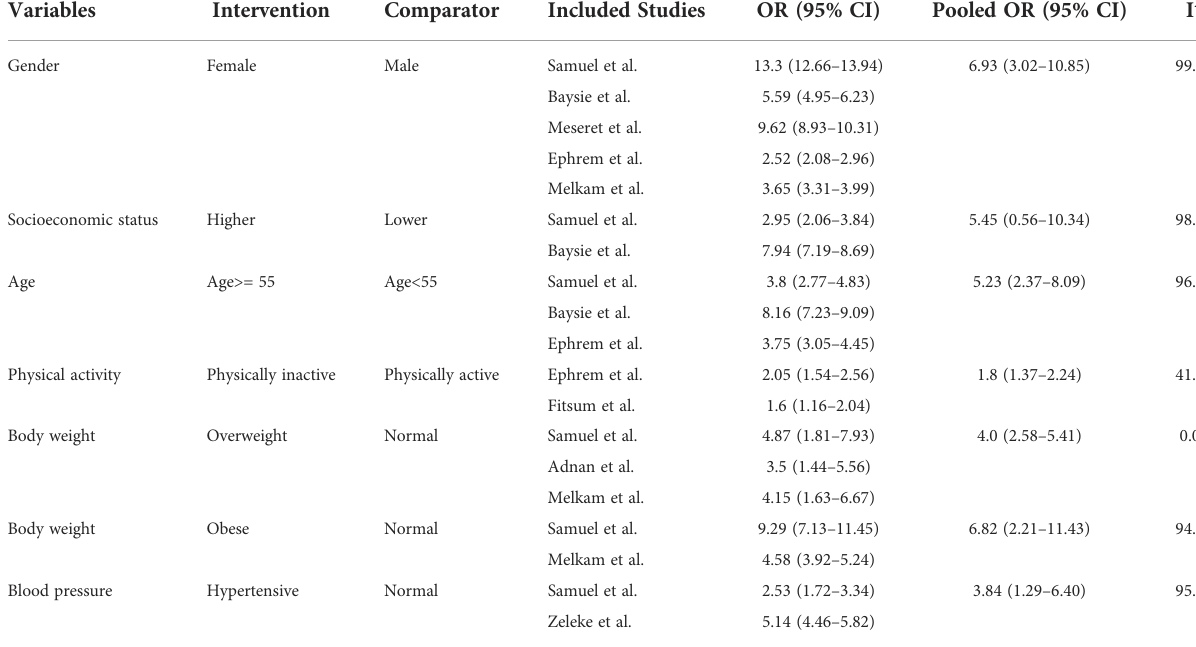
TABLE 2 Summary estimate of OR for central obesity – associated